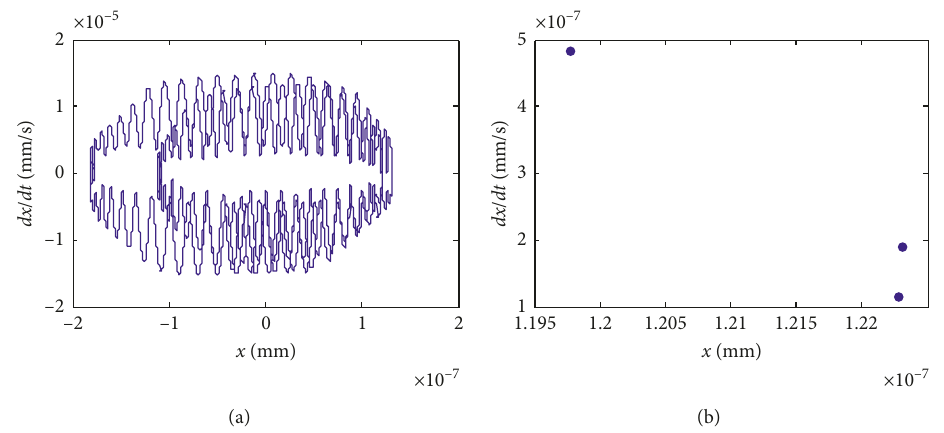
Figure 2: System response for ω � 3000r/min. (a) Phase portraits. (b) Poincar´e map.